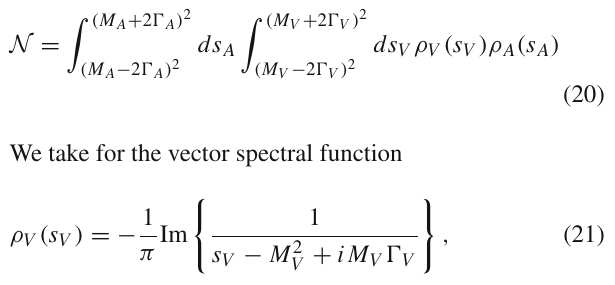
Table 7 Branching ratios (in %) for creation of the different axial- vector resonances. The τ − → ν τ a 1 ( 1260 ) is fixed to the experimental result as reference Decay